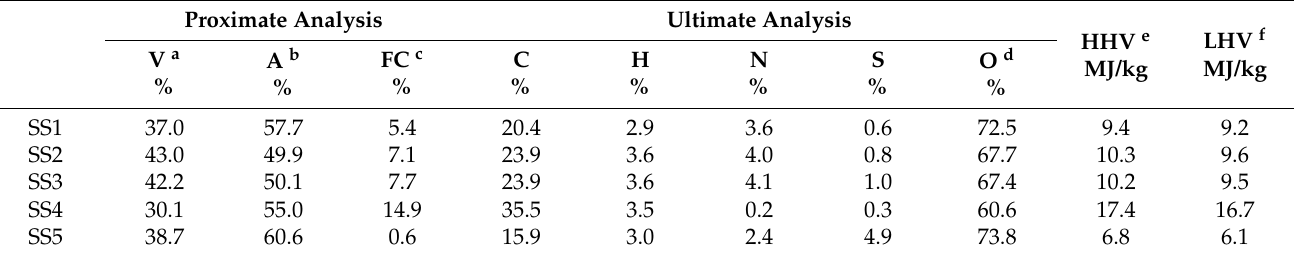
Table 1. Basic fuel properties of the SS.